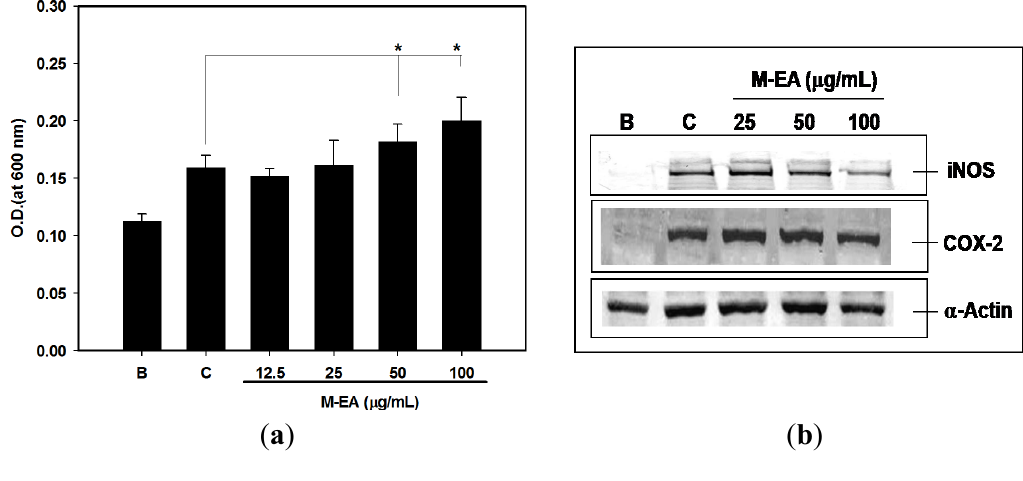
Figure 5. Dose responses of the M-EA on LPS-activated splenocytes. The activity of splenocytes was detected by an MTT assay at 600 nm ( a ). Values are presented as the mean ± SD, n = 3, each with triplicate samples. B: without LPS treatment, C: treatment with LPS and 0.1% DMSO. * p < 0.05. The iNOS and COX-2 expressions of splenocytes were measured by western blotting assay ( b ).  -Actin was used as an internal control to identify equal amounts of protein loading in each lane. The results were detected from three separate experiments, from which one picture is